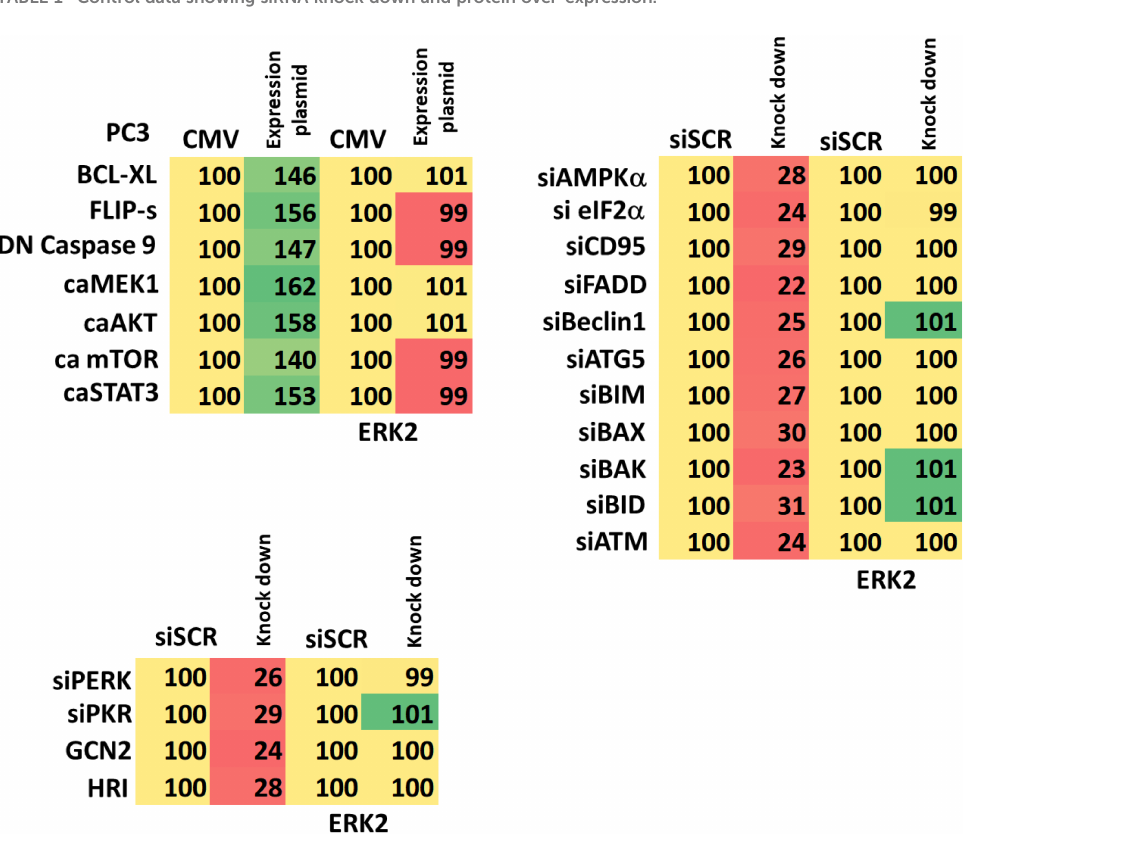
TABLE 1 Control data showing siRNA knock down and protein over-expression.